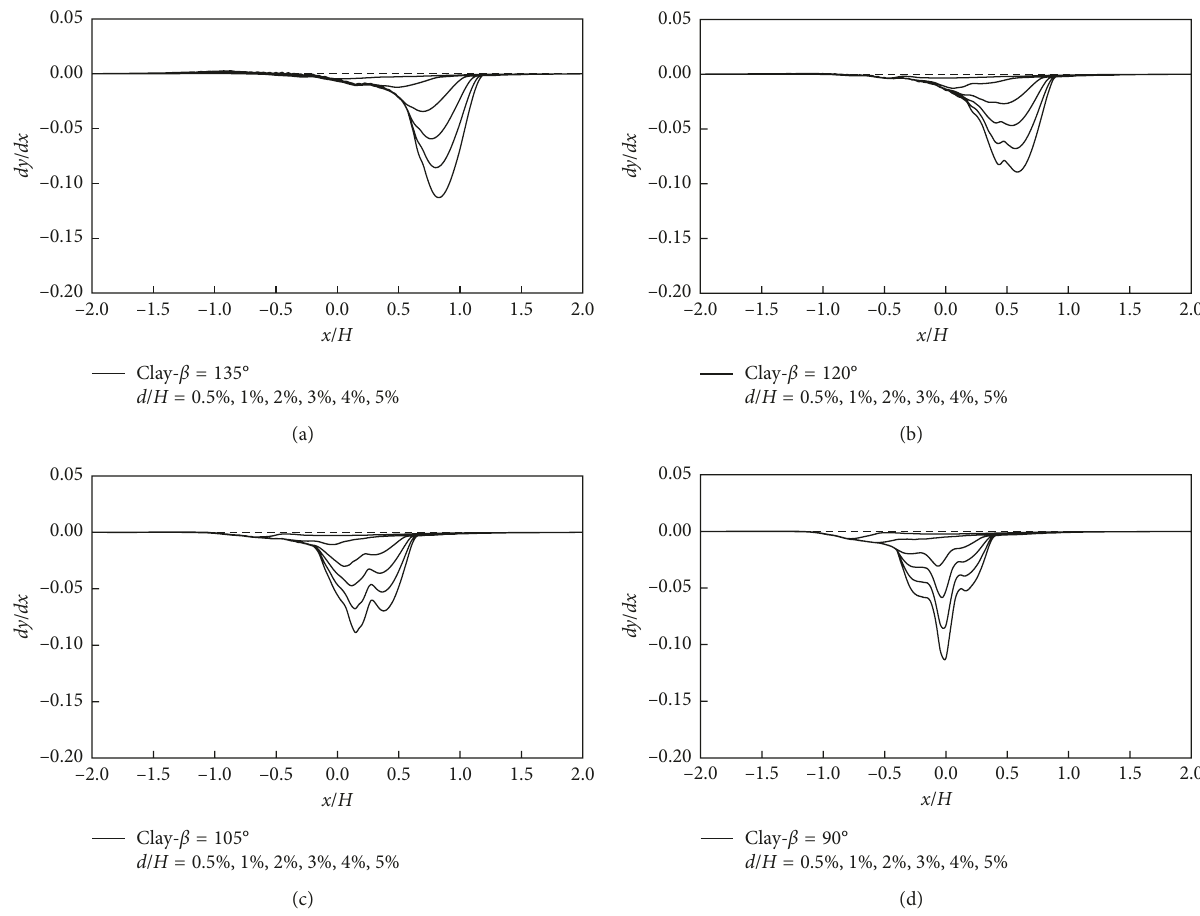
Figure 14: The ground incline curves with different dip angles for the reverse fault in clay: (a) 45 ° , (b) 60 ° , (c) 75 ° , and (d) 90 ° .